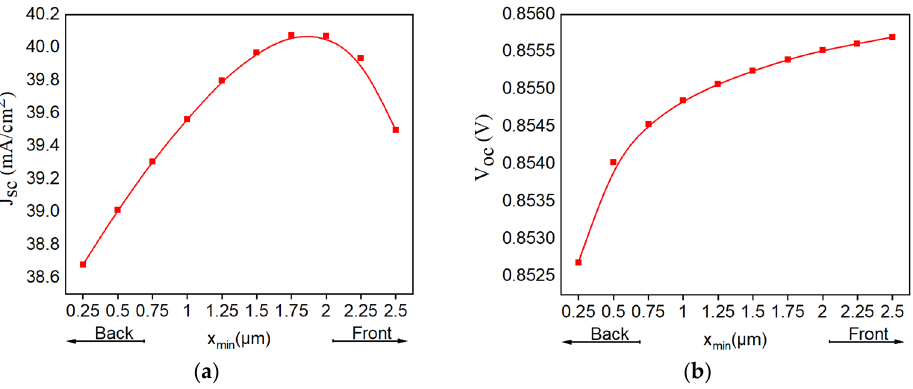
Figure 7. Comparing the effects of notch position ( x min ) on ( a ) J SC ; ( b ) V OC of the cell with the incorporation of DG bandgap